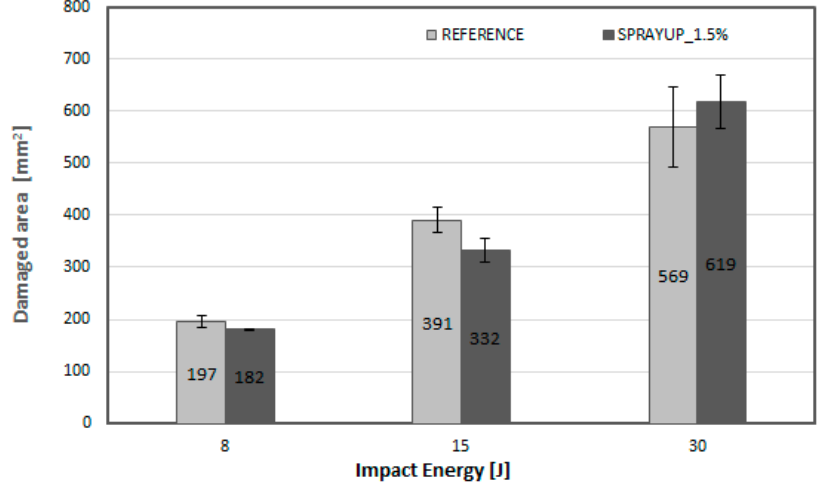
Figure 6. Delamination area versus impact energy levels for both the reference material and the nano ‐ modified with 1.5 wt.% MWCNTs concentration.